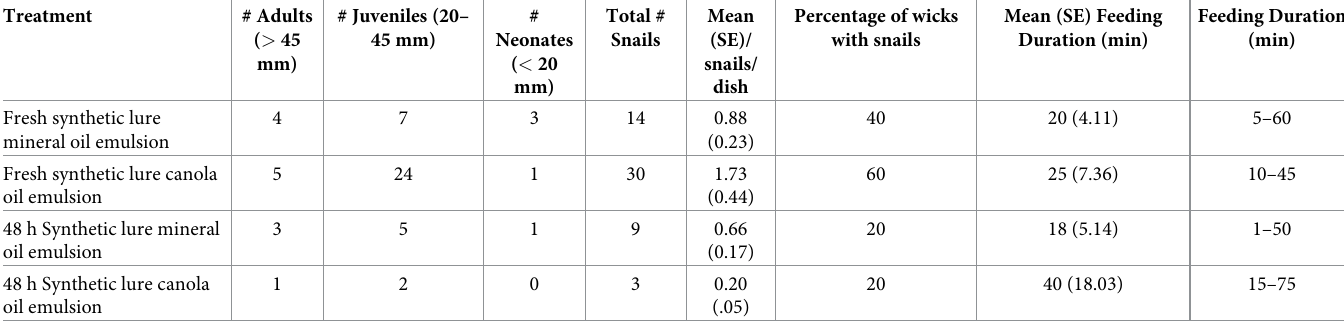
Table 3. The number of individual giant African snails ( Lissachatina fulica ) observed feeding on wicks saturated with fresh and aged (48h) synthetic lure (0.2%) in a canola or mineral oil emulsion. Emulsions were 1:1:0.2 water/oil/Tween 1 80.